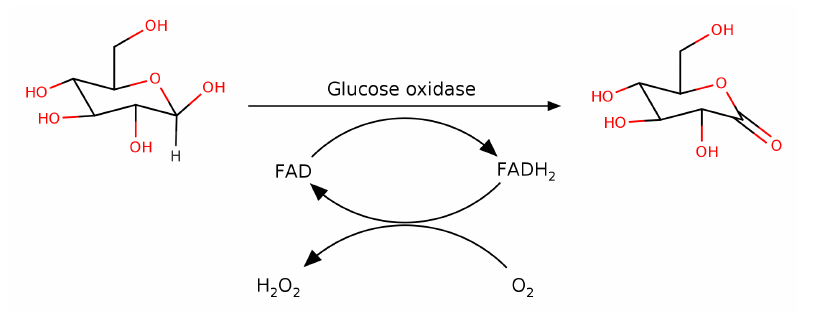
Figure 1. The general reaction of